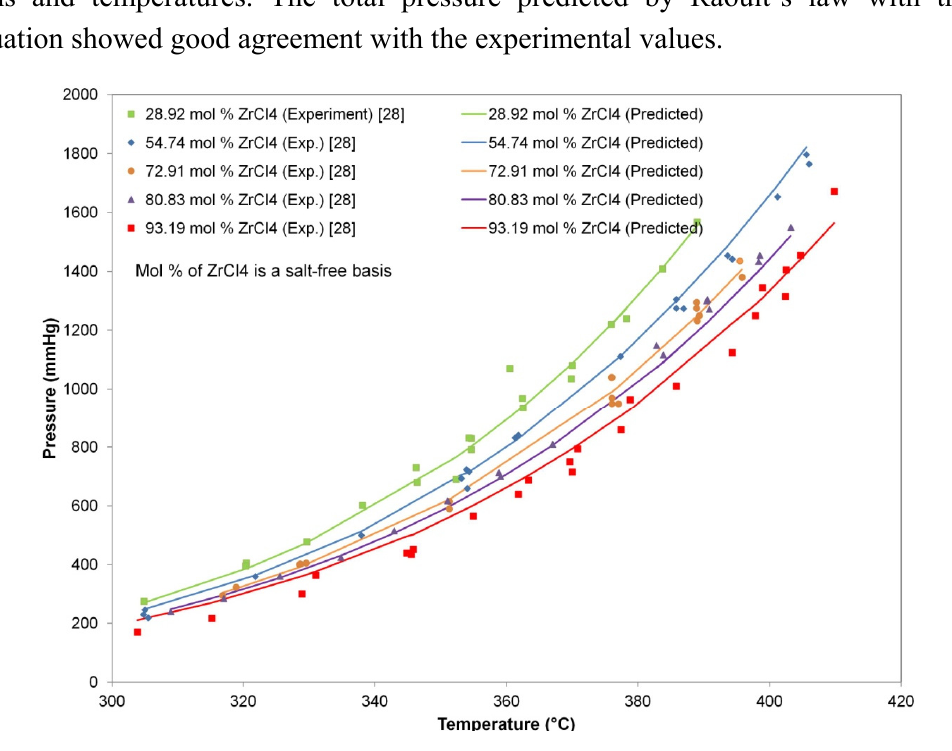
Figure 1. Comparison of the predicted and experimental results of the total pressure for different ZrCl 4 compositions in the molten salt system (34.0 mol% NaCl and KCl (8:29 M); 66.0 mol% ZrCl 4 and HfCl 4